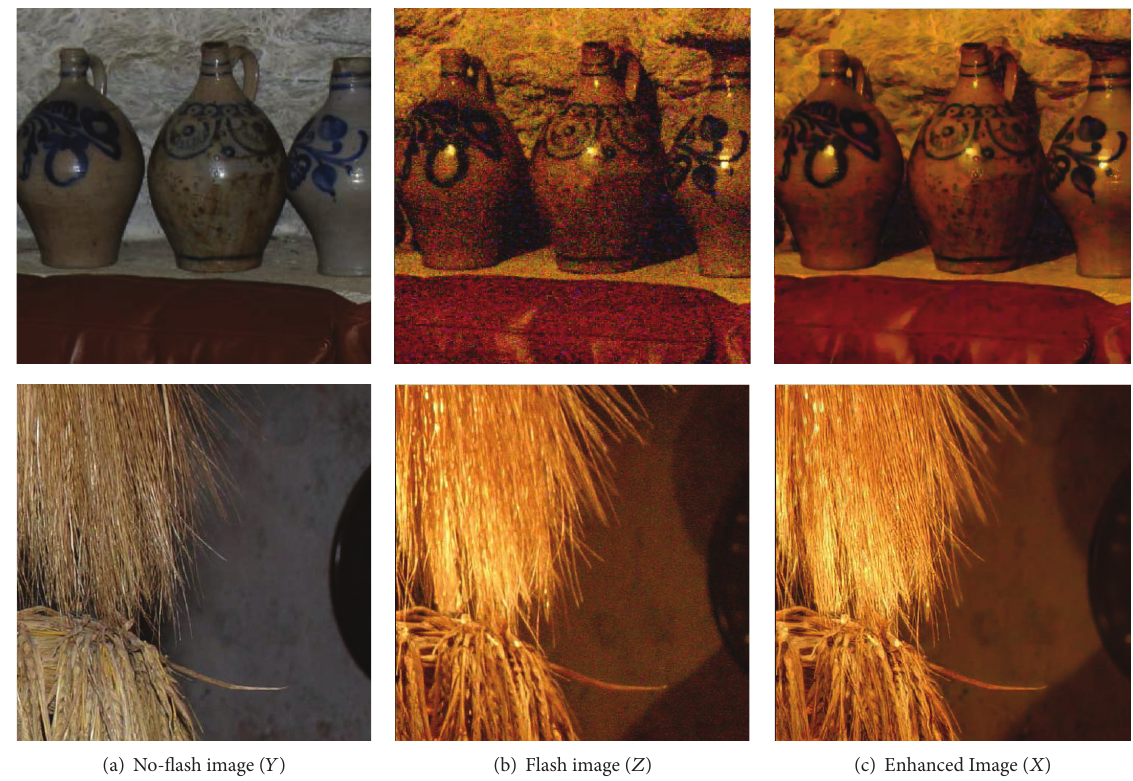
Figure 2: Image enhancement from real flash/no-flash image pairs.